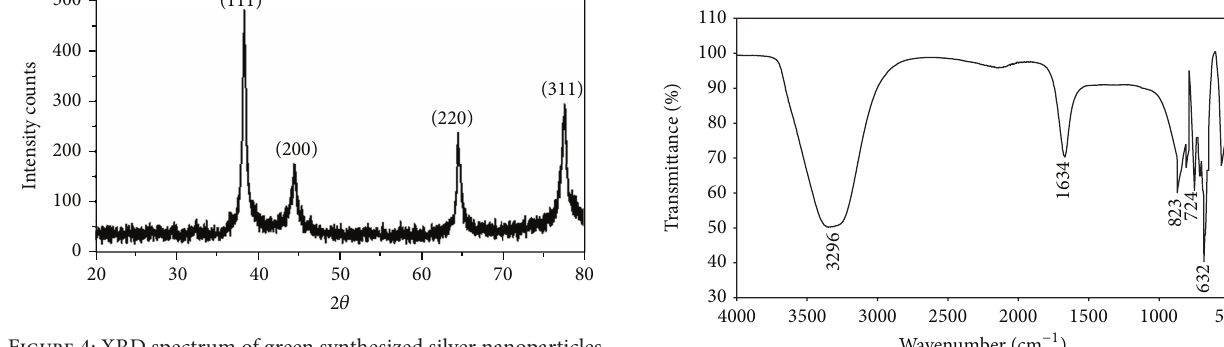
Figure 4: XRD spectrum of green synthesized silver nanoparticles.